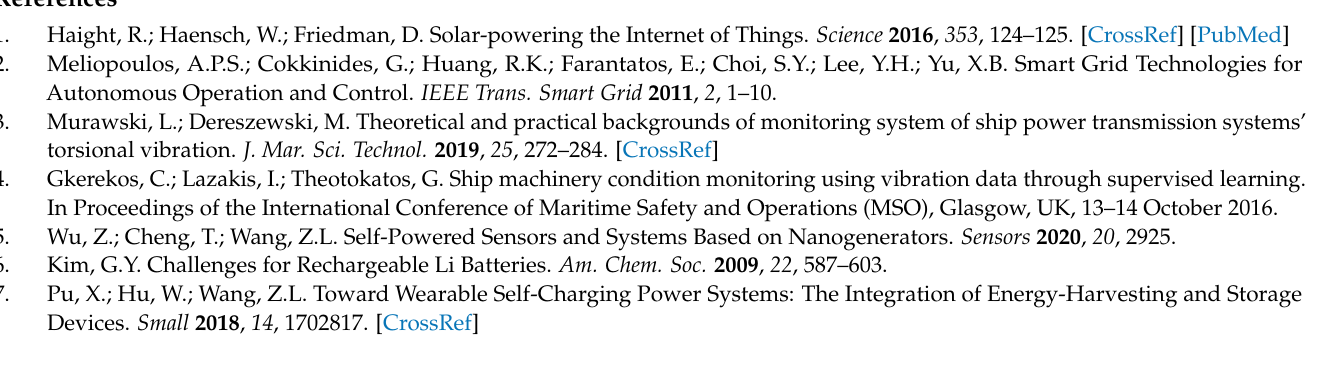
N-C model. Figure S2: Testing system for SRS-TENG. Figure S3: Performance comparison between the SRS-TENGs with double electrodes and a single electrode. Figure S4: Performance comparison between the SRS-TENGs with or without surface treatment of the strip. Figure S5: Performance comparison among the SRS-TENGs with different strip widths of 22, 30 and 42 mm. Figure S6: Performance comparison among the SRS-TENGs with different strip thicknesses of 0.48, 0.86, and 1.2 mm. Figure S7: Performance comparison among the SRS-TENGs with different air gaps of 5, 10 and 15 mm. Table S1: Spin-coater parameter setting for different strip thickness. Video S1: Strip moving status under vibration frequencies of 10, 30 and 50 Hz with an amplitude of 1 mm. Video S2: Powering of a temperature sensor by the SRS-TENG. Video S3: Lighting up 112 LEDs by the SRS-TENG. Video S4: Demonstration of amplitude sensing. Video S5: Demonstration of vibration alarm